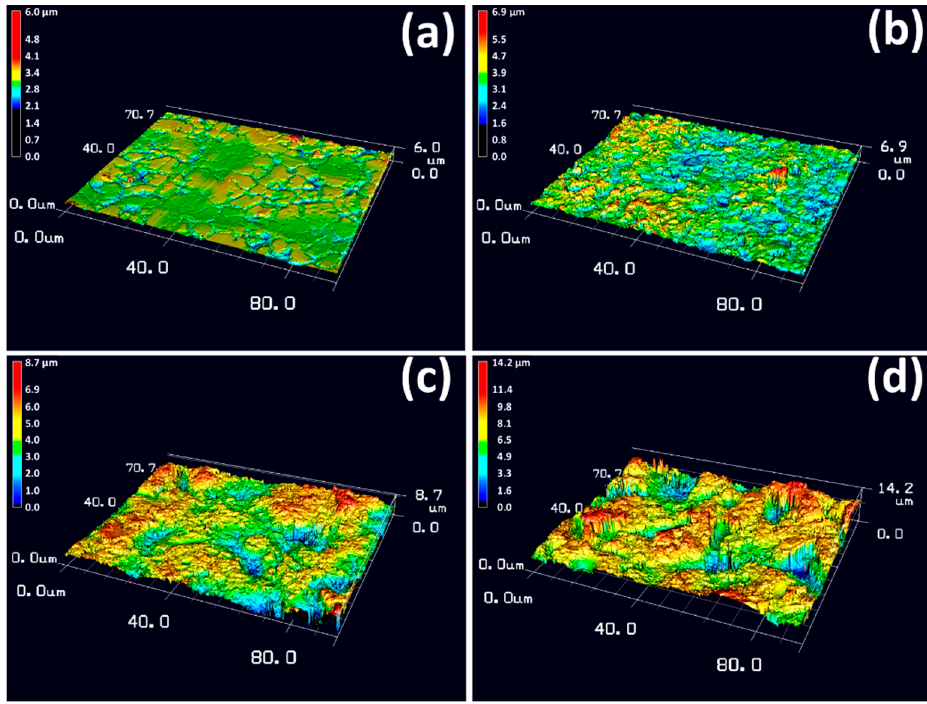
Figure 4. Three dimensional images of the surface of ( a ) S0, ( b ) S14, ( c ) S3 and ( d ) S14-3.